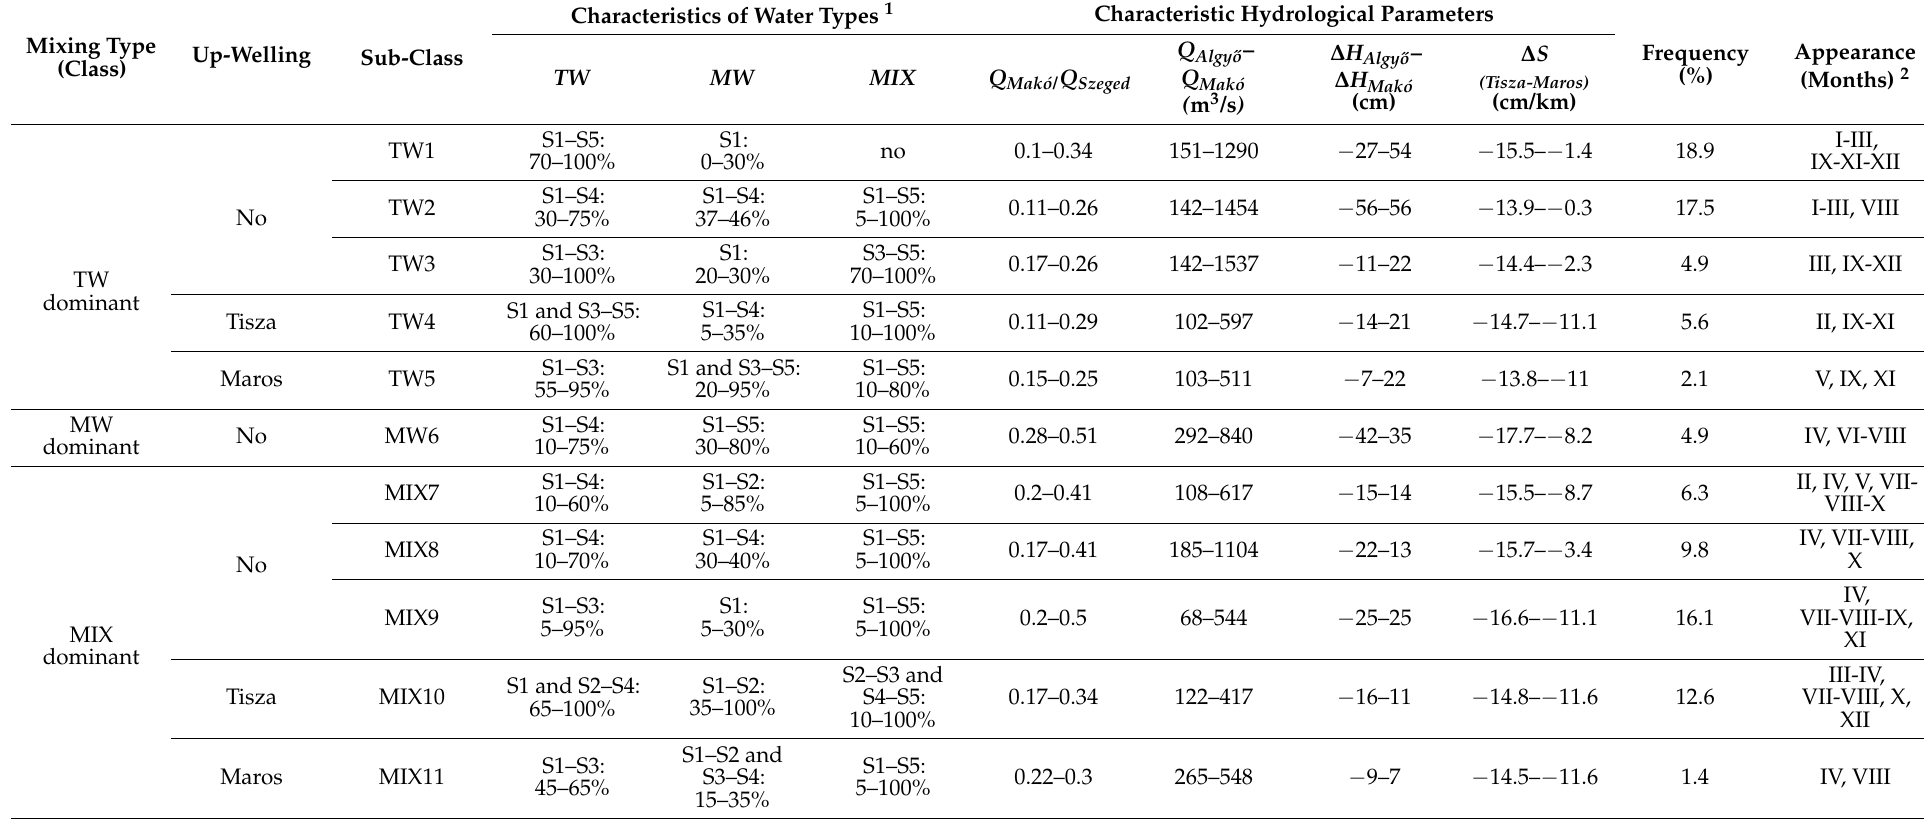
Table 4. Main characteristics of the identified mixing